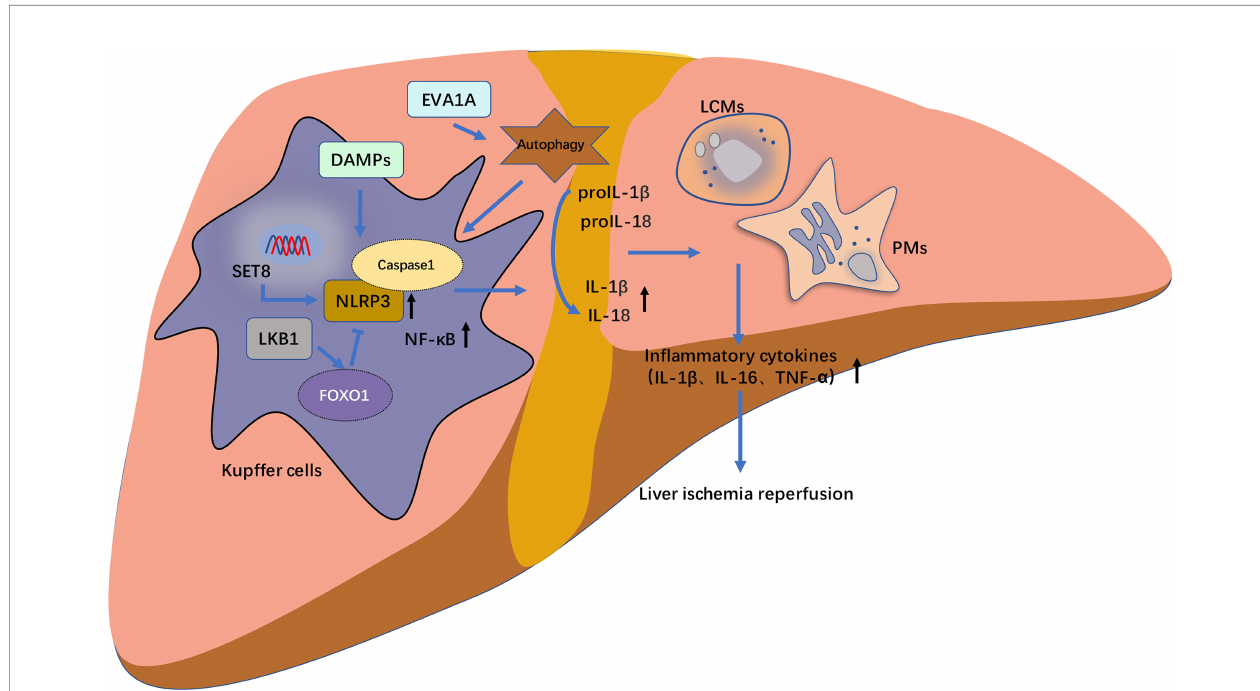
FIGURE 3 | The schematic diagram of NLRP3 in fl ammasome activation pathway of hepatic macrophages in liver ischemia – reperfusion injury (LIRI). The release of caspase-1 and following cell death of pyroptosis mediated by NLRP3 in fl ammasome activation pathway frequently occurs in hepatic macrophages including Kupffer cells (KCs), liver capsular macrophages (LCMs), monocyte-derived and peritoneal macrophages (PMs). These hepatic macrophages regulate on another and modulate the progression of LIRI-related NLRP3 in fl ammasome activation through the release of in fl ammatory cytokines such as IL1 b , IL18 and TNF- a . In RAW 264.7 cells (mice macrophages), SET domain-containing protein 8 (SET8) negatively regulate LIRI in fl ammatory responses and ameliorate liver injury through the inhibition of MARK4/NLRP3 in fl ammasome activation pathway. Eva-1 homologous gene A (EVA1A) is upregulated in in fl ammatory responses of LIRI in Kupffer cells (KCs), in which its overexpression induces more formation of autophagosomes. Whereas EVA1A silencing can promote ASC activation and increase the cleavage of caspase 1 and IL1 b by activating autophagy. Liver kinase B1 (LKB1) alleviates LIRI by inhibiting the activation of NLRP3 in fl ammasome and NF- k B. Additionally, this inhibitory effect could be mediated through the forkhead box protein O1